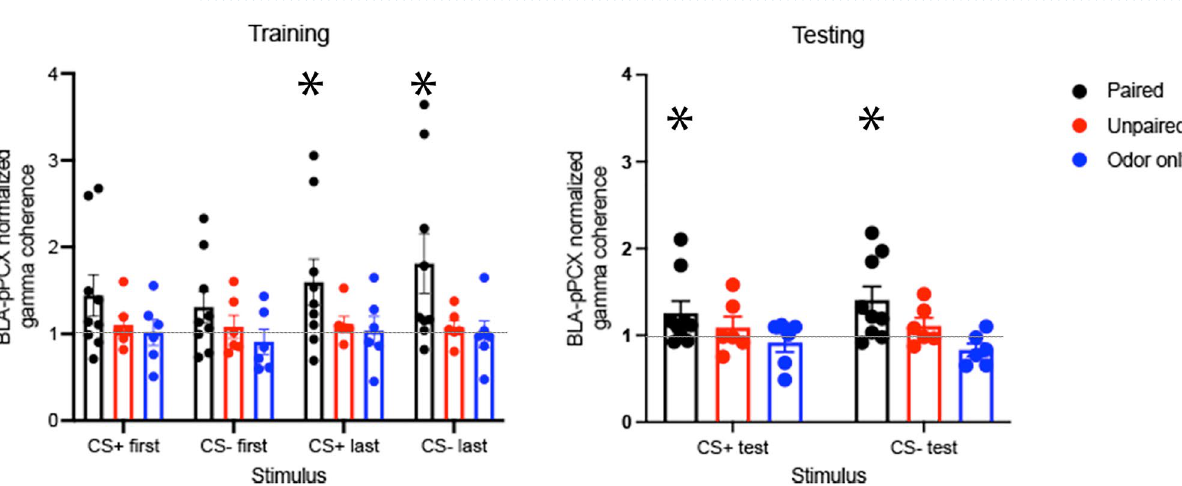
Figure 4. Odor-evoked BLA-pPCX LFP coherence in the high gamma band normalized to spontaneous coherence in the homecage. During training, coherence was significantly greater in Paired animals than either control group (ANOVA group X stimulus interaction, p < 0.05) with the largest differences expressed over the last 5 trials of the CS+ and CS−. The odor-evoked BLA-pPCX coherence was enhanced during training and test compared to that observed in the homecage only in Paired animals (asterisks signifies significant difference from 1.0, p < 0.05) and not in either control (ANOVA, p = 0.36, NS). Normalized BLA-pPCX gamma coherence increased over the course of paired condi- tioning compared to controls (3 × 4, group X stimulus ANOVA, main effect of stimulus, F(6,54) = 3.05, p = 0.012, group X stimulus interaction, F(1,25) = 3.99, p = 0.044). Planned post-hoc tests to determine whether coherence had significantly changed from that observed in the home cage showed that BLA-pPCX coherence during the last five presentations of the CS+ and CS− were significantly enhanced only in the Paired animals. Paired ani- mals showed normalized odor-evoked coherence significantly greater than 1 during the last 5 trials to both the CS+ and CS− (t-tests, p < 0.05), while Unpaired and Odor-only controls did not, suggesting an enhancement in connectivity over the course of training. Twenty four hours post conditioning, when tested in a novel context, BLA-pPCX gamma coherence was significantly enhanced to both the CS+ and CS− in Paired animals com- pared to Controls (3 X 2 group X stimulus interaction, ANOVA, main effect of group, F(2,18) = 3.72, p = 0.044). Paired animals showed normalized odor-evoked coherence significantly greater than 1 during testing to both the